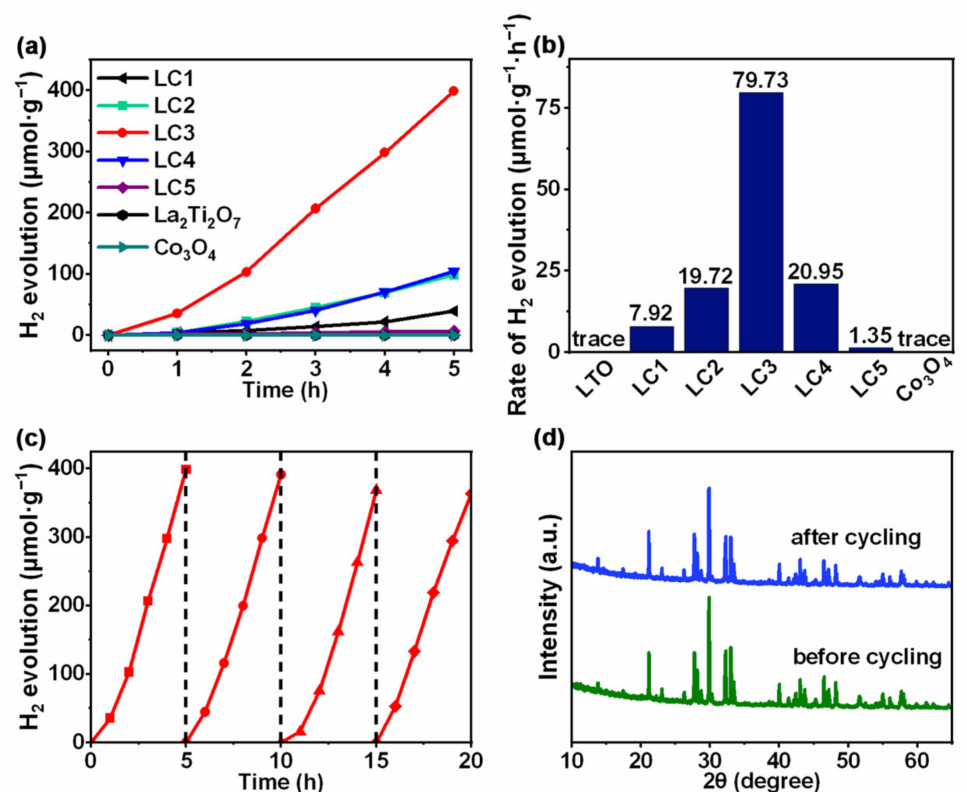
Figure 5. ( a ) Time courses of photocatalytic H 2 evolution of La 2 Ti 2 O 7 , Co 3 O 4 , and composite; ( b ) H 2 evolution rates of La 2 Ti 2 O 7 (LTO), Co 3 O 4 and composite; ( c ) Cycling experiment of H 2 evolu- tion for LC3; ( d ) XRD patterns of LC3 before and after the cycling